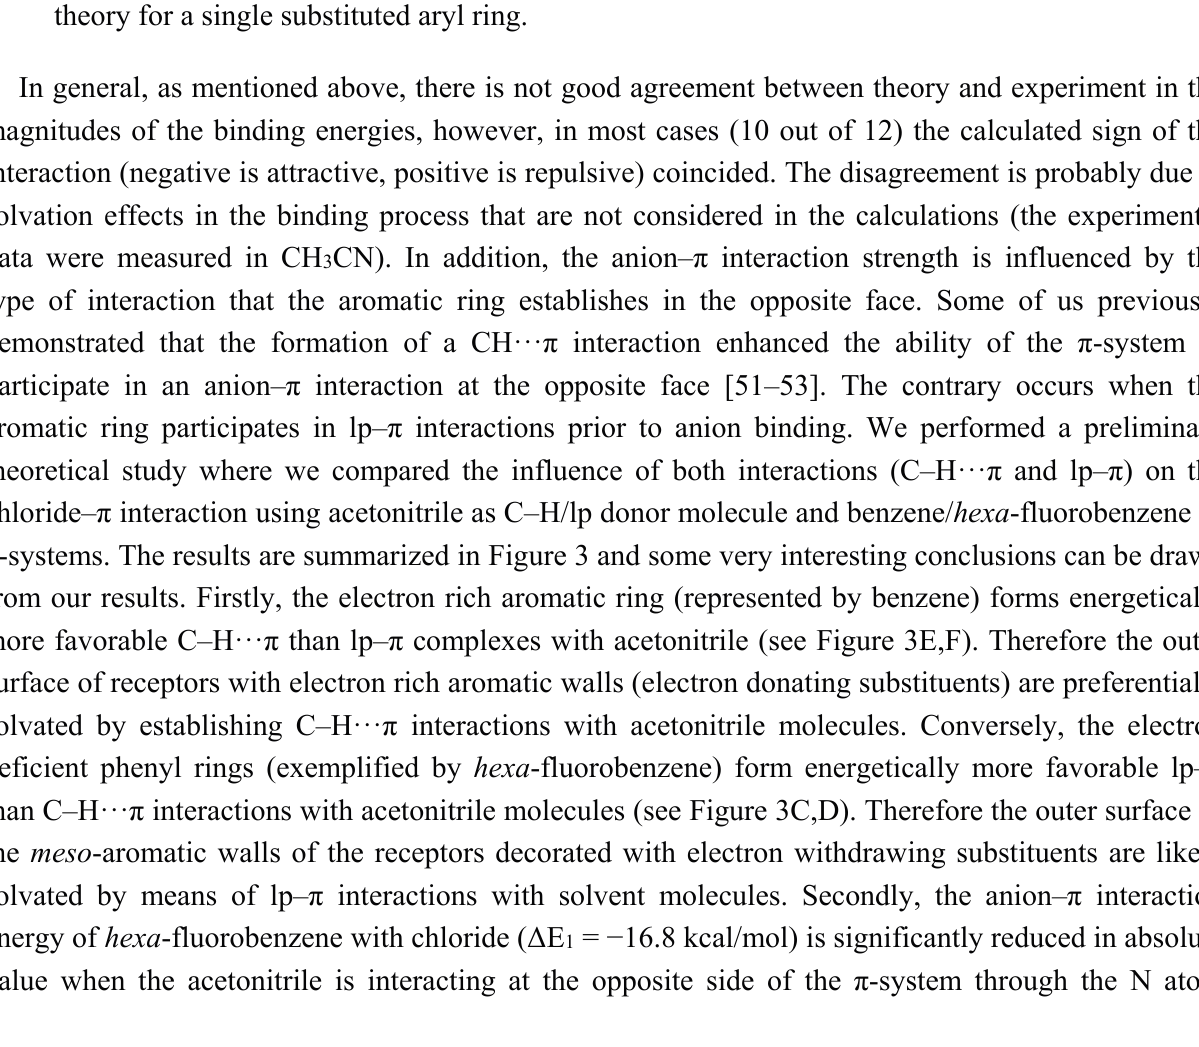
Figure 2. Regression plots of the statistically corrected (SC) experimental ΔΔ G and theoretical ΔΔ E magnitudes vs. the electrostatic surface potential (ESP) value at the center of the aryl rings. The ESP values were calculated at the RI-MP2/aug-cc-pVDZ level of theory for a single substituted aryl